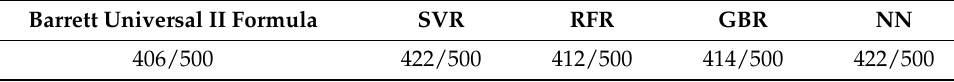
Figure 6. Mean absolute prediction error of the SRK/T formula and machine learning methods. Mean absolute error for the SRK/T formula, SVR, GBR, RFR, and NN were 0.3314, 0.2877, 0.2929, 0.2964, and 0.2891, respectively. The p -value by the Friedman test was < 0.0001. The SVR formula vs. the SRK/T formula: p < 0.0001; GBR vs. the SRK/T formula: p < 0.0001; RFR vs. the SRK/T formula: p = 0.0001; NN vs. the SRK/T formula: p < 0.0001; (The p -values were calculated using the Wilcoxon signed-rank test and were adjusted using the Bonferroni correction). Table 3. Proportion of objects with errors less than 0.5 D.